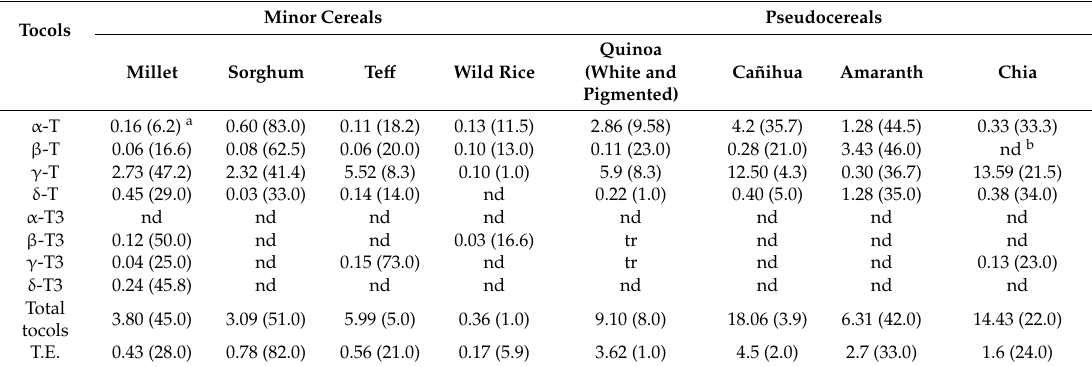
Table 4. Tocol composition in gluten-free grains (mg / 100g